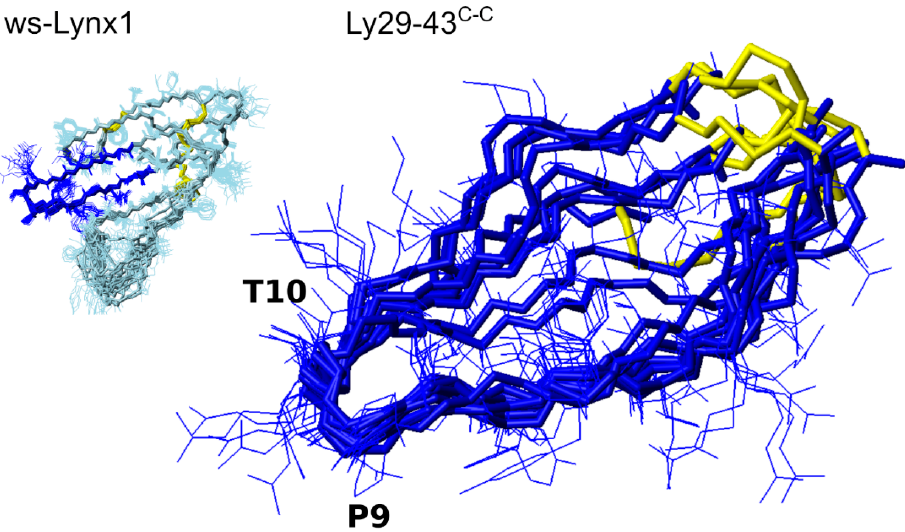
Figure 7. At top shown is the structure of ws-Lynx1 [26] with the loop II highlighted in dark blue. At bottom, the 10 best NMR structures of Ly29–43 C-C out of 100 calculated are superimposed over the backbone atoms of residues 3–14. Disulfide bridges are highlighted in yellow .